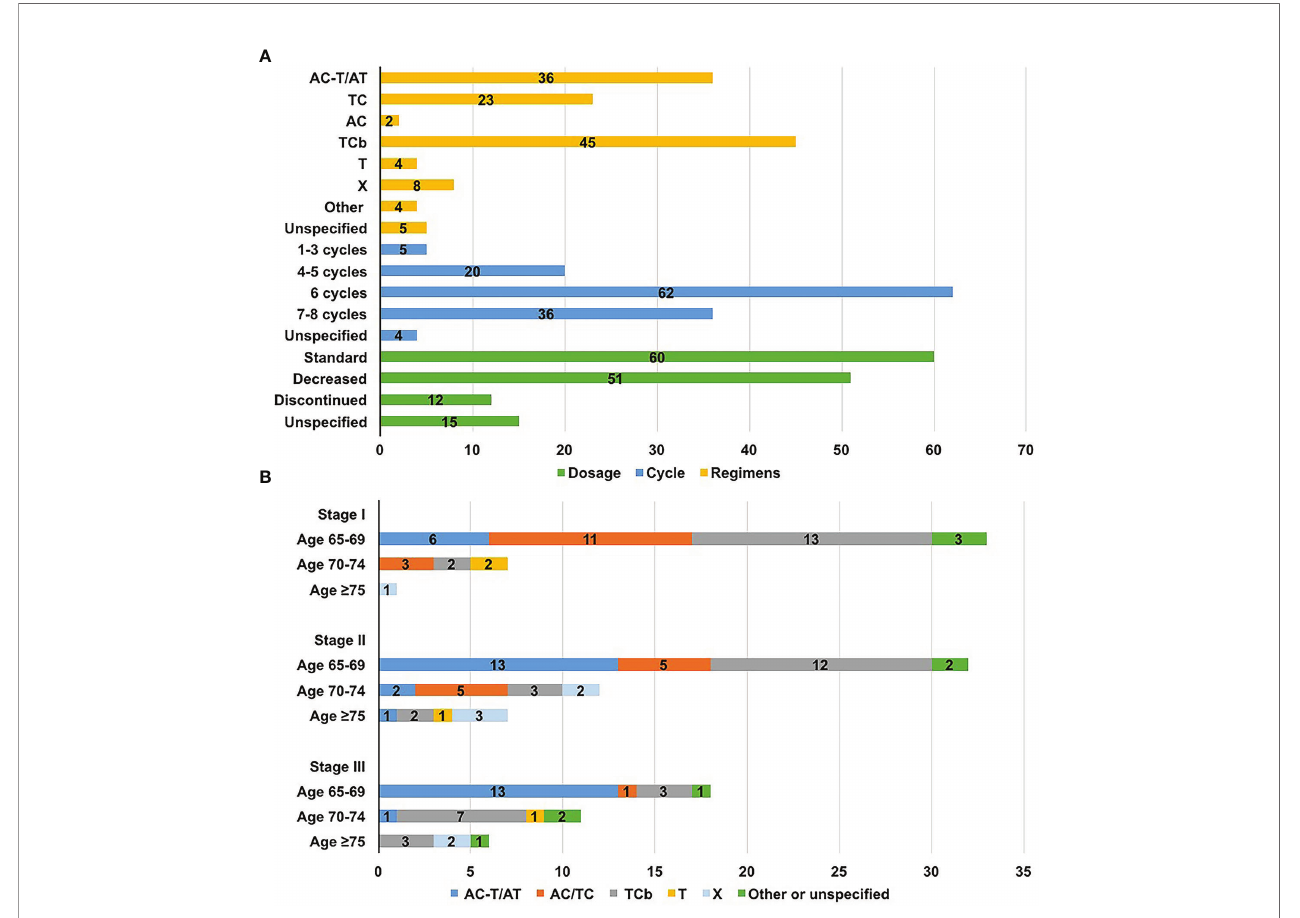
FIGURE 2 | Chemotherapy distributions for older women with triple-negative breast cancer. (A) Distribution of regimens, dosage, and the number of cycles; (B) Distribution of regimens according to age and stage. A, anthracyclines, including epirubicin or pirarubicin; C, cyclophosphamide; Cb, carboplatin; T, taxane, including docetaxel or paclitaxel; X,